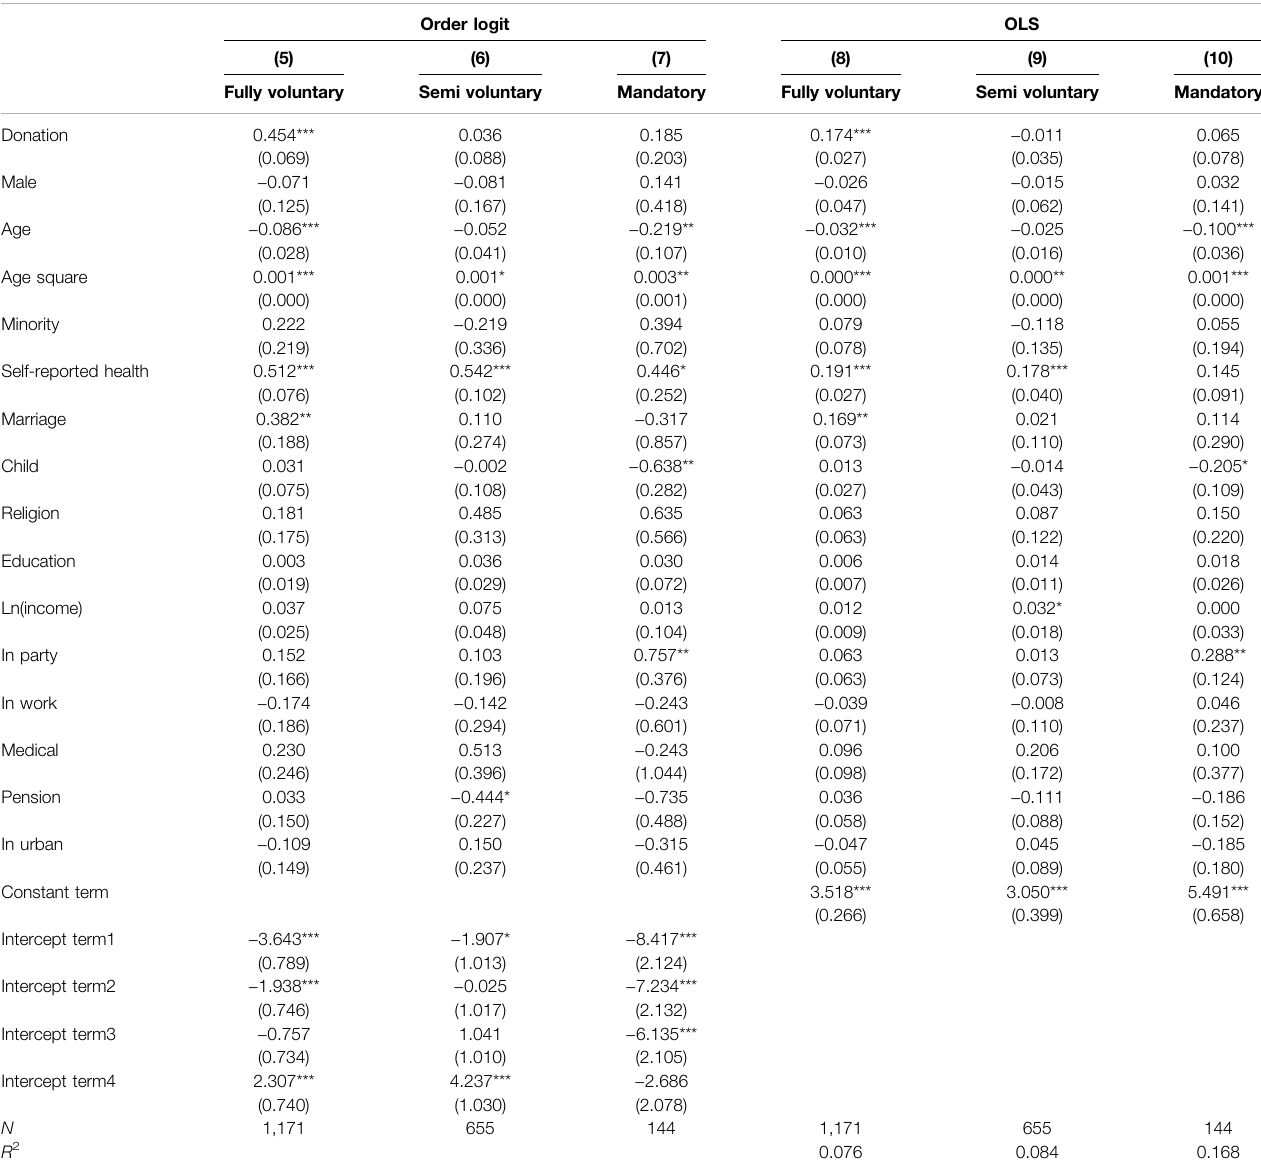
TABLE 6 | Discussion of different degree of Autonomy.